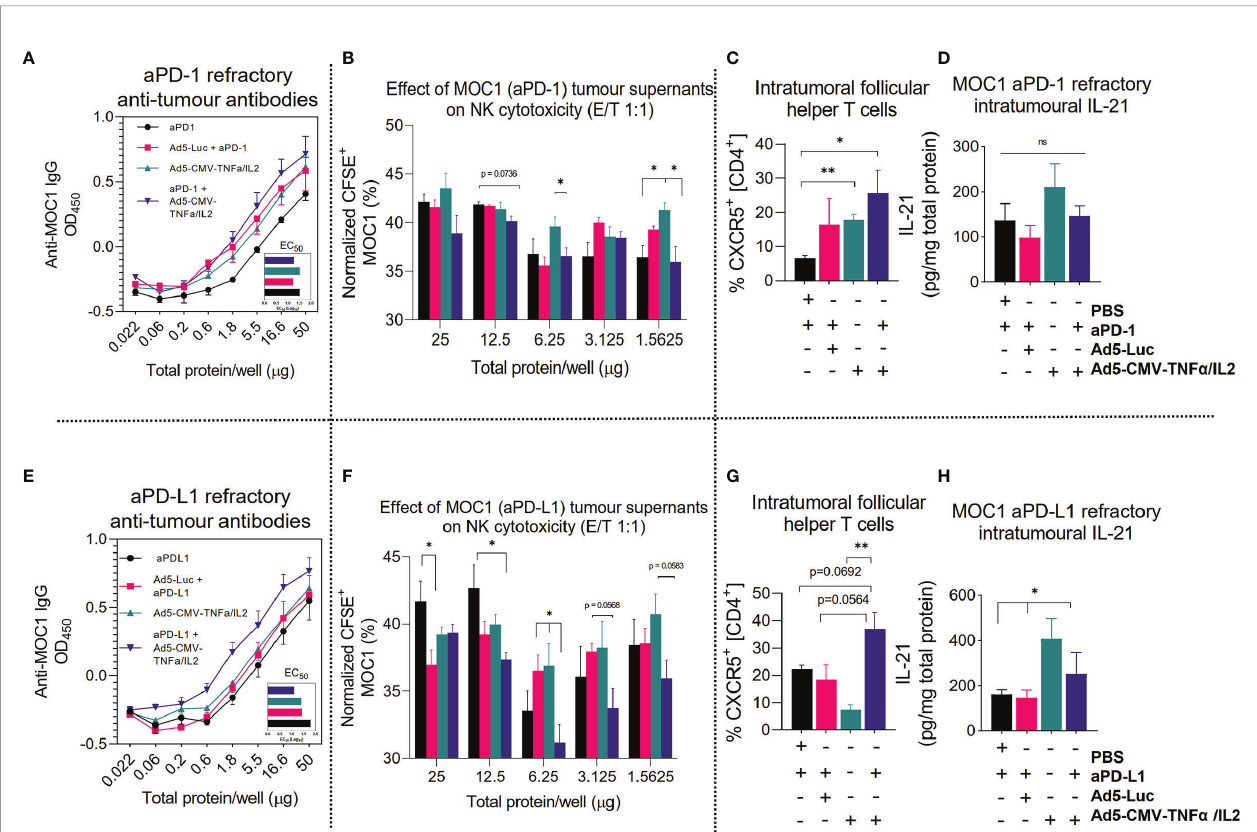
FIGURE 5 | Combining ICI with non-replicative Ad5-CMV-mTNF a /mIL-2 improves tertiary lymphoid structure associated antitumor response. (A, E) Anti-MOC1 antibodies derived from MOC1 anti-PD-1/L1 refractory tumor digests supernatants and their respective treatment groups cultured with MOC1 cell line and measured by total IgG + signal using In-cell ELISA. (B, F) corresponding effects of whole tumor digests on NK-mediated cell killing of MOC1 in vitro . NK cells were derived from fresh C57BL/6J mouse spleens and isolated by negative selection magnetic bead based approach. (C, G) Flow cytometric analysis of CD4 + , CD8 + , CXCR5 + , tumor in fi ltrating lymphocytes from (C) anti-PD-1 and (G) anti-PD-L1 refractory mice. (D, H) Measurement of intratumoural IL-21 concentrations as measured by ELISA and normalized to total protein concentration. Data sets were evaluated for statistical signi fi cance by non-parametric unpaired t test and shown as means ± SEM with signi fi cance represented as *p < 0.05, **p < 0.01, ns, not signi fi